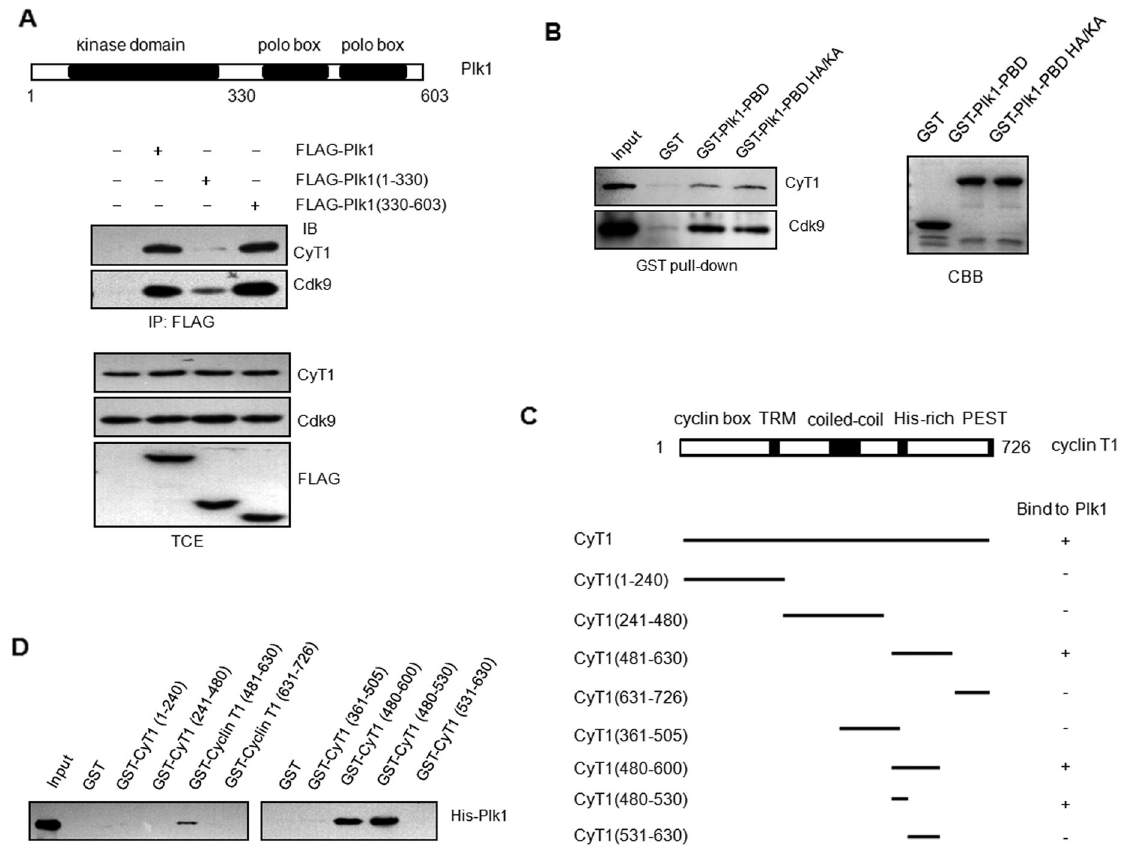
Figure 2. Identification of binding region of Plk1 and cyclin T1. (A) 293T cells were transfected with pCMV FLAG-Plk1or the indicated Plk1 deletion mutants, or empty vector as the control. The total cell extracts were immunoprecipitated with FLAG antibody and immunoblotted with Cdk9 and cyclin T1 antibody respectively. (B) GST pull-down assay. Equivalent amount of cell lysates from 293T cells were incubated with immobilized GST, GST-Plk1 polo-box domain (PBD) or GST-Plk1 PBD H538A/K540A, whose residues crucial for PBD phosphopeptide binding were mutated to alanine, followed by immunoblotting with Cdk9 and cyclin T1 antibody. (C) Structure of human cyclin T1 and cyclin T1 truncations. (D) GST-cyclin T1 and its truncations and His-Plk1 were purified and subjected to GST pull-down assay. doi: